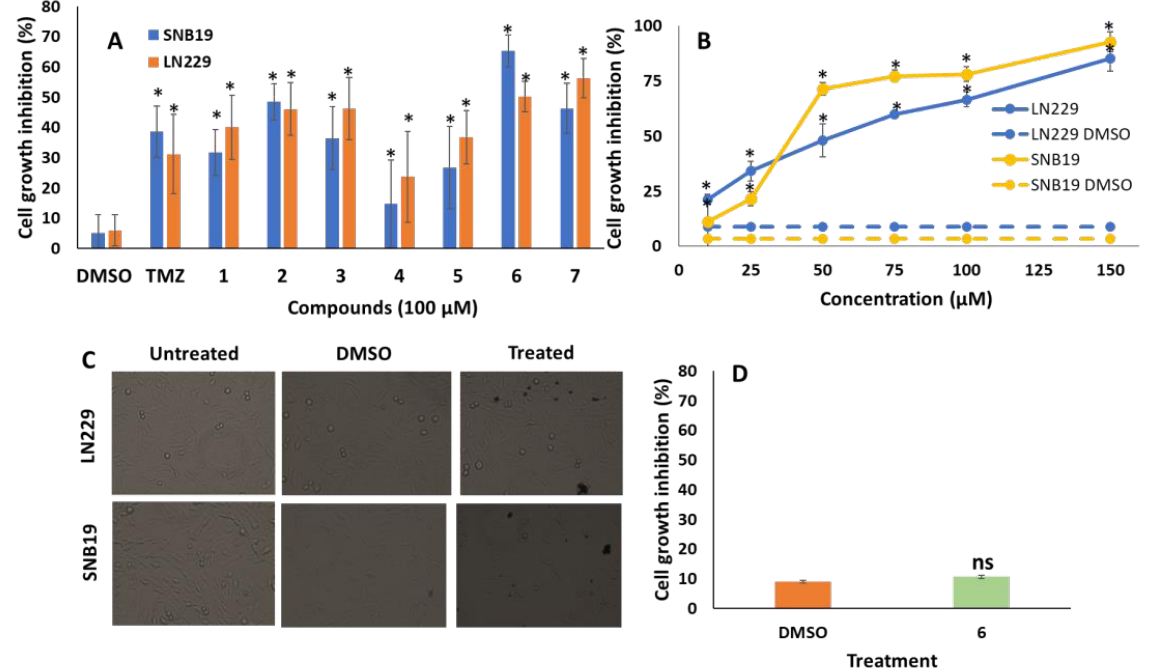
Figure 3. ( A ) Effect of compounds 1–7 against the growth of GBM cells, LN229 and SNB19. ( B ) Effect of compound 6 in LN229 and SNB19 cells. Percentage of cell viability for LN229 and SNB19 cell lines upon treatment with compound 6 at different concentrations, 10 µ M, 25 µ M, 50 µ M, 75 µ M, 100 µ M, and 150 µ M. Datapoints and error bars represent mean ± S.E.M (n = 6). ( C ) Phase contrast images of GBM cells in untreated, DMSO-treated, and IC 50 concentration of compound 6 . ( D ) Percentage of cell growth inhibition in the MEF cell line treated with compound 6 at a 100 µ M concentration.